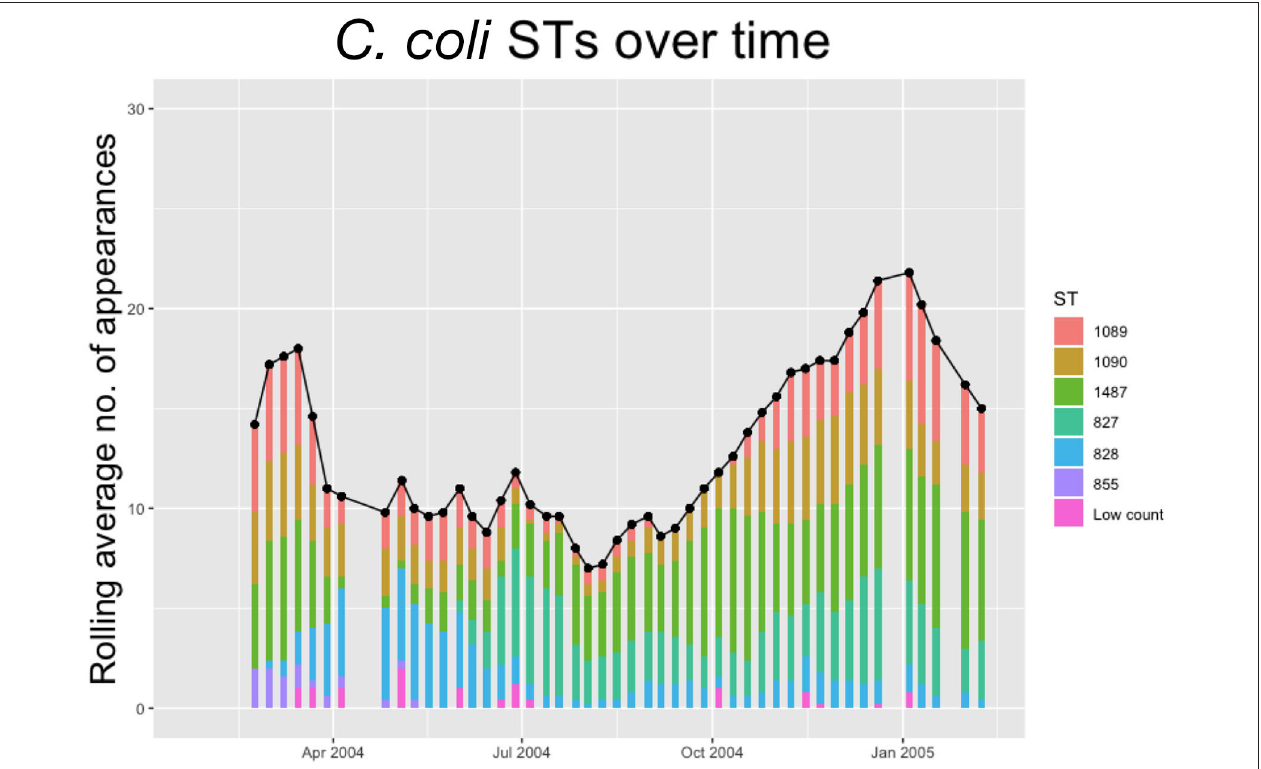
FIGURE 3 | The 5-weeks rolling average number of positive samples for Campylobacter coli , with both the total number and separate ST averages. STs that appear < 10 times throughout the entire experiment are amalgamated into a group “Low Count”.